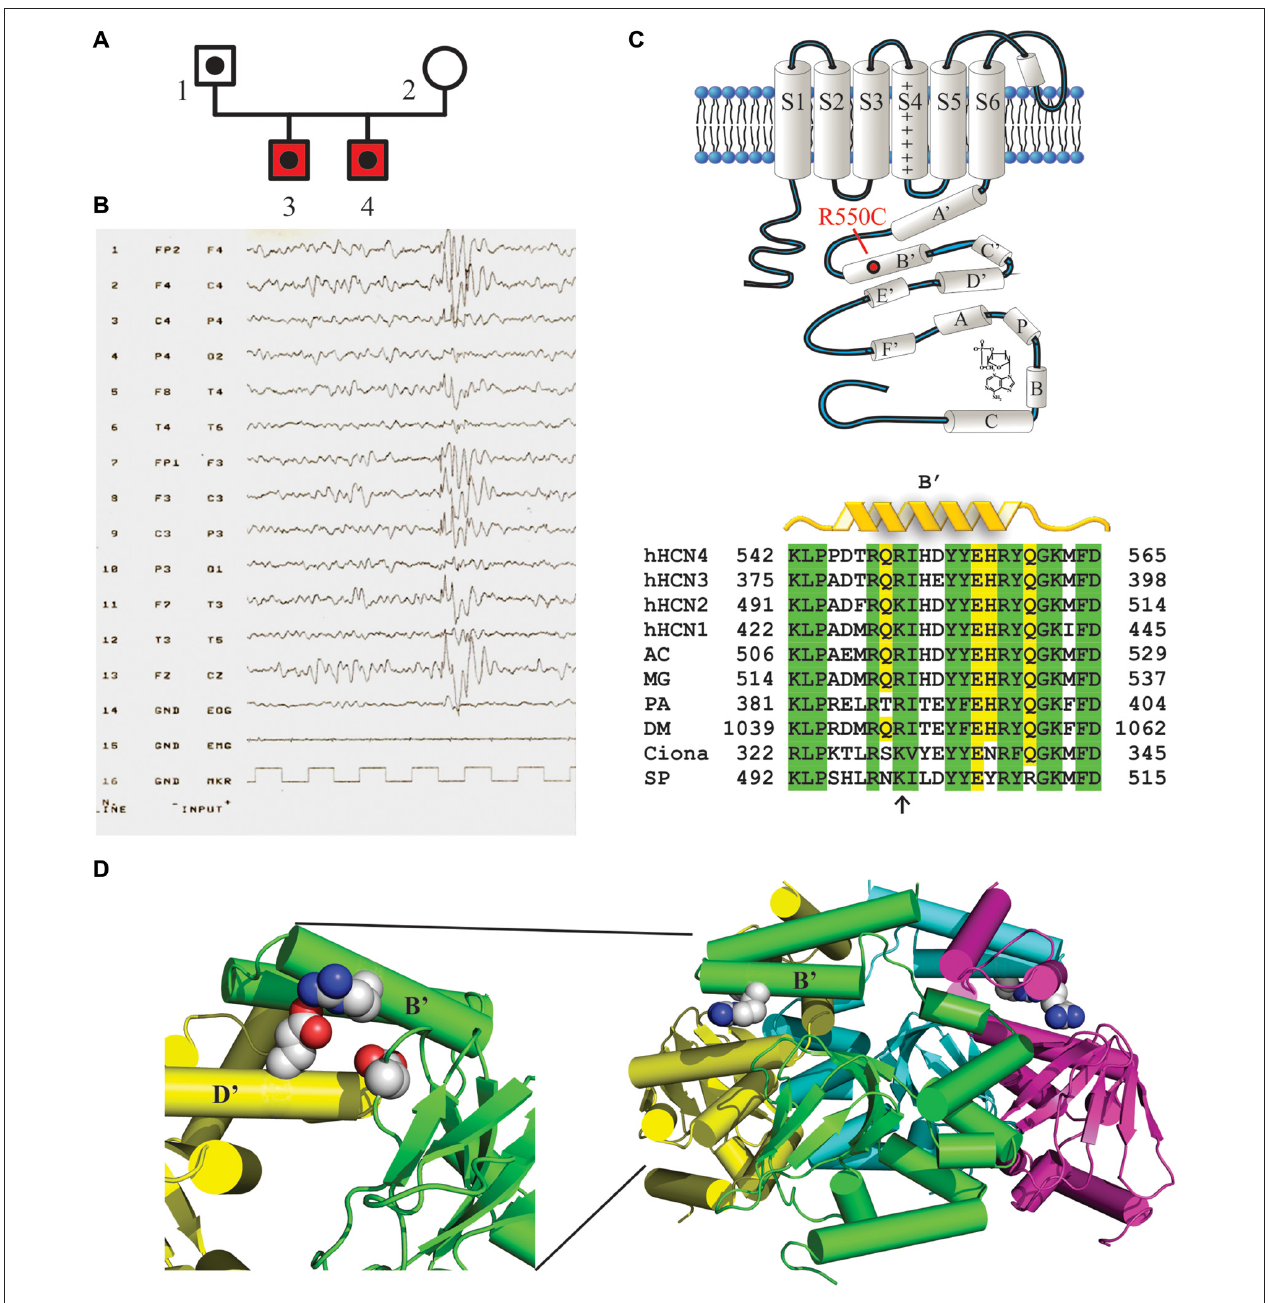
FIGURE 1 | Mutation R550C found in the HCN4 C-linker region of epileptic siblings. (A) Family pedigree. Dotted symbols represent individuals carrying the HCN4 R550C mutation in heterozygosis (probands and their father); red symbols indicate reported diagnosis of benign myoclonic epilepsy of infancy. (B) EEG of patient 3 showing normal background, with generalized epileptiform activity prevalent in the anterior regions. ( C , top) Schematic representation of one HCN4 channel subunit showing the six transmembrane domains (S1–S6) and the intracellular N- and C-termini. The C-terminus includes the C-linker, comprising six α -helices (A (cid:48) to F (cid:48) ), and the cyclic nucleotide-binding domain (CNBD, A to C), as indicated. The approximate position of the mutation R550C in the B’ helix is also shown. ( C , bottom) Sequence alignment of the B’ helix of the four human HCN channel isoforms (hHCN4 NP_005468.1, hHCN1 NP_066550.2, hHCN2 NP_001185.3, hHCN3 NP_065948.1) and of homologous channel regions in other species. Note that at position hHCN4:R550 a positively charged amino acid (arrow) is conserved in all species indicated. AC, Anolis carolinensis (XP_008119223.1); MG, Meleagris gallopavo (XP_010715467.1); PA, Panulirus argus (AAQ16311.1); DM, Drosophila melanogaster (NP_001137667.1); Ciona, Ciona intestinalis (AFB83348.1); SP, Strongylocentrotus purpuratus (NP_999729.1). ( D , right) Ribbon 3D representation of the tetrameric arrangement of hHCN4 C-termini, comprising C-linkers and CNBDs, based on X-ray crystallographic data (Xu et al., 2010; PDB ID: 3OTF). R550 residues in B’ α -helices are drawn as space-filling plots. ( D , left) Expanded and rotated view showing residues R550 (green B’ helix), E580 (yellow D’ helix) and D620 (green β -roll), which may act as salt-bridges (Craven and Zagotta, 2004).